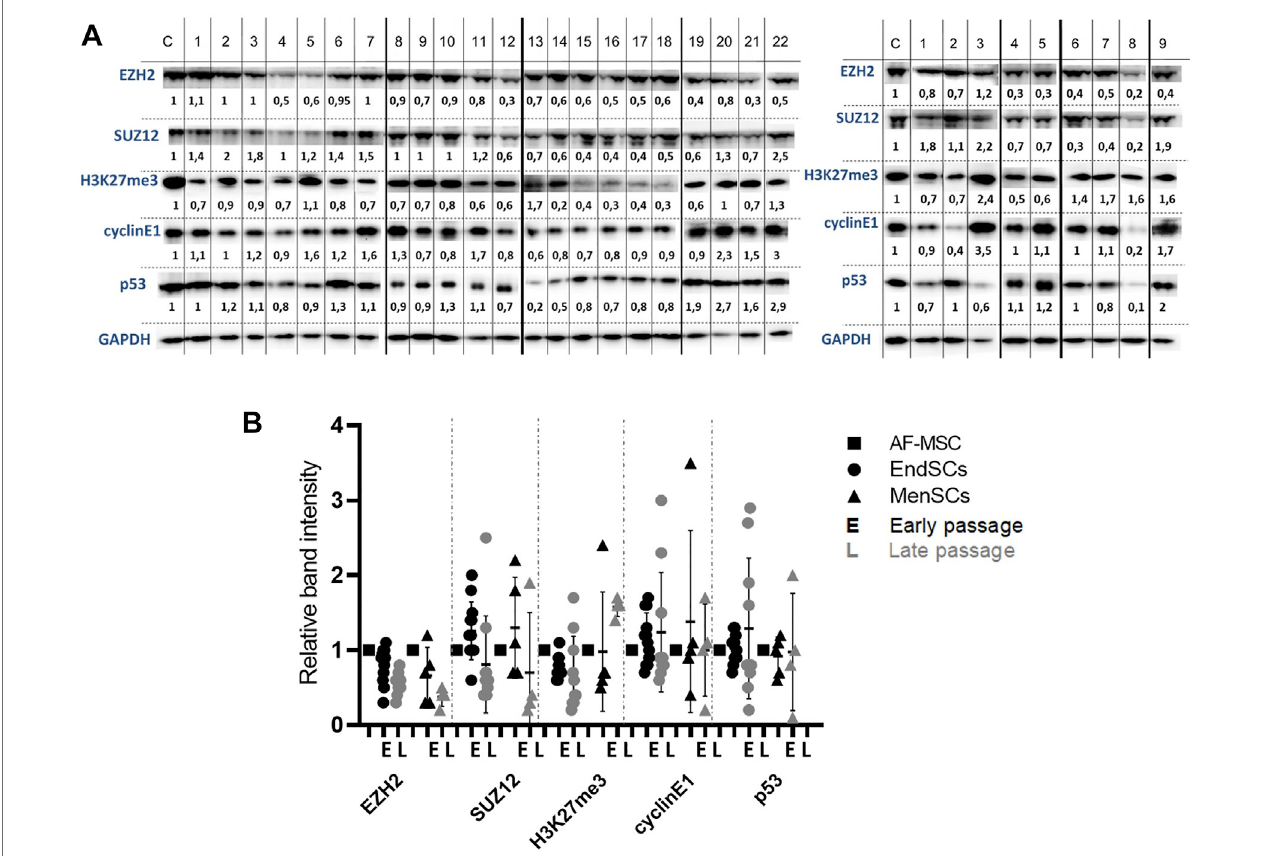
FIGURE 5 | Evaluation of protein level changes in EndSCs and MenSCs. (A) C — control cells (AF-MSCs), 1 – 22 and 1 – 9 — depicts different patients. Left panel shows EndSCs samples, right panel — MenSCs samples. Changes in protein EZH2, SUZ12, H3K27me3, cyclin E1 and p53 levels in early and late passages of EndSCs and MenSCs were determined using Western blot analysis. Relative protein intensity of bands was calculated using ImageJ software and presented under each band. Data were normalized to the GAPDH loading control. (B) A graphical representation of detected protein level changes as calculated by ImageJ software and normalizedtotheGAPDHloadingcontrol.Resultsarepresentedasmean ± SD( n (cid:2) 6).Nostatisticallysigni fi cantchangesweredetectedbetweendifferentpassagesand cell groups as evaluated by one-way